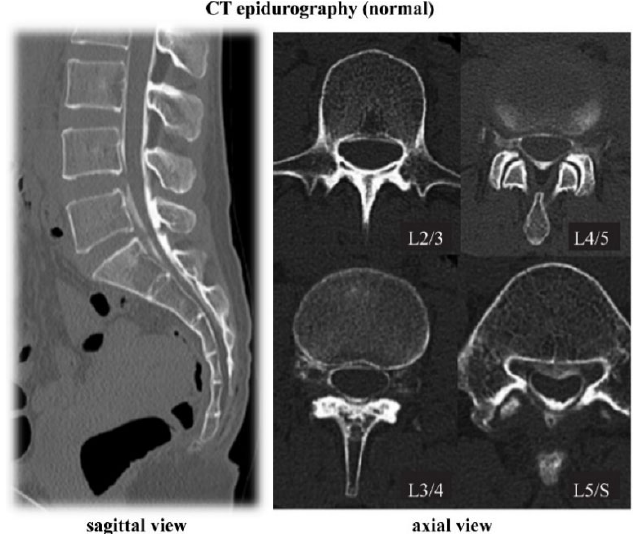
Figure 2. CT epidurography (normal). Sagittal view and axial view. CT, computed tomography.